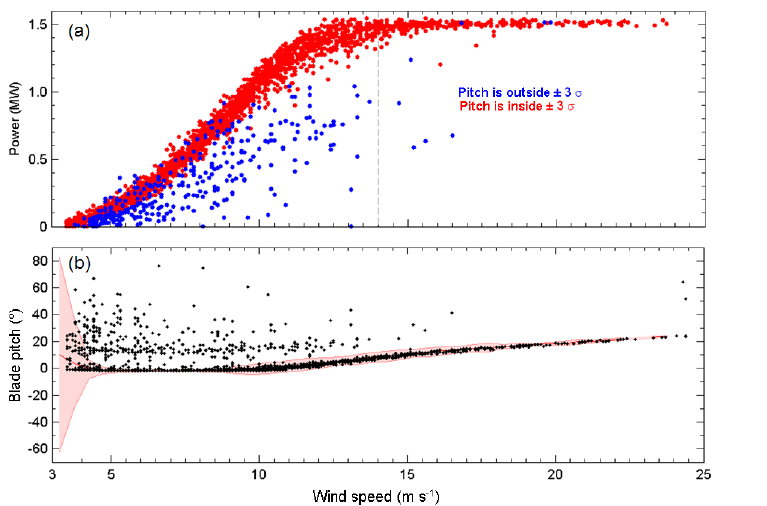
Figure 5. (a) Scatter power curve based on the tower 80m wind speed. Blue dots show points that are outside of the median absolute deviation (MAD) envelope in (b) and the red dots represent points that are within the MAD envelope in (b) . The vertical grey dashed line marks rated speed. (b) Blade pitch angle from a single blade vs. tower 80m wind speed. Red envelope represents ± 4.5MAD of the blade pitch angle within wind speed bins 0.5ms − 1